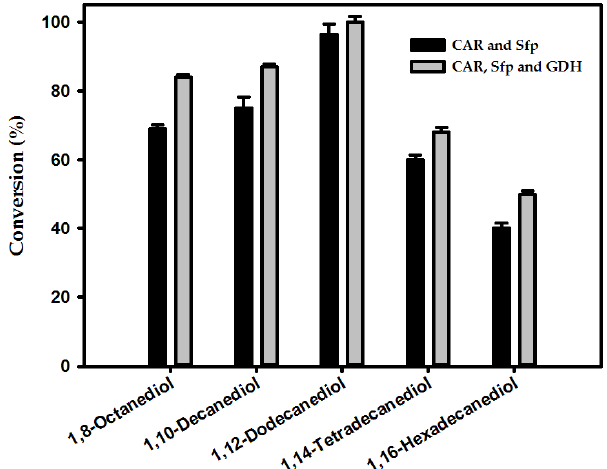
Figure 6. In vivo production of α , ω‐ diols using E. coli BW25113 ( ∆ fadD, DE3) cells expressing MmCAR and Sfp with/without GDH. Reaction conditions: Substrate, 3 mM biotransformed ω‐ OHFAs (C 8 –C 16 ); Reaction time, 24 h; Volume, 10 mL in 100 mL flask; Temp, 30 °C; Buffer, 100 mM potassium phosphate buffer (pH: 7.5) with 1% glucose ( w / v ) and 10 mM MgCl 2 ; Cell OD 600 , 30.